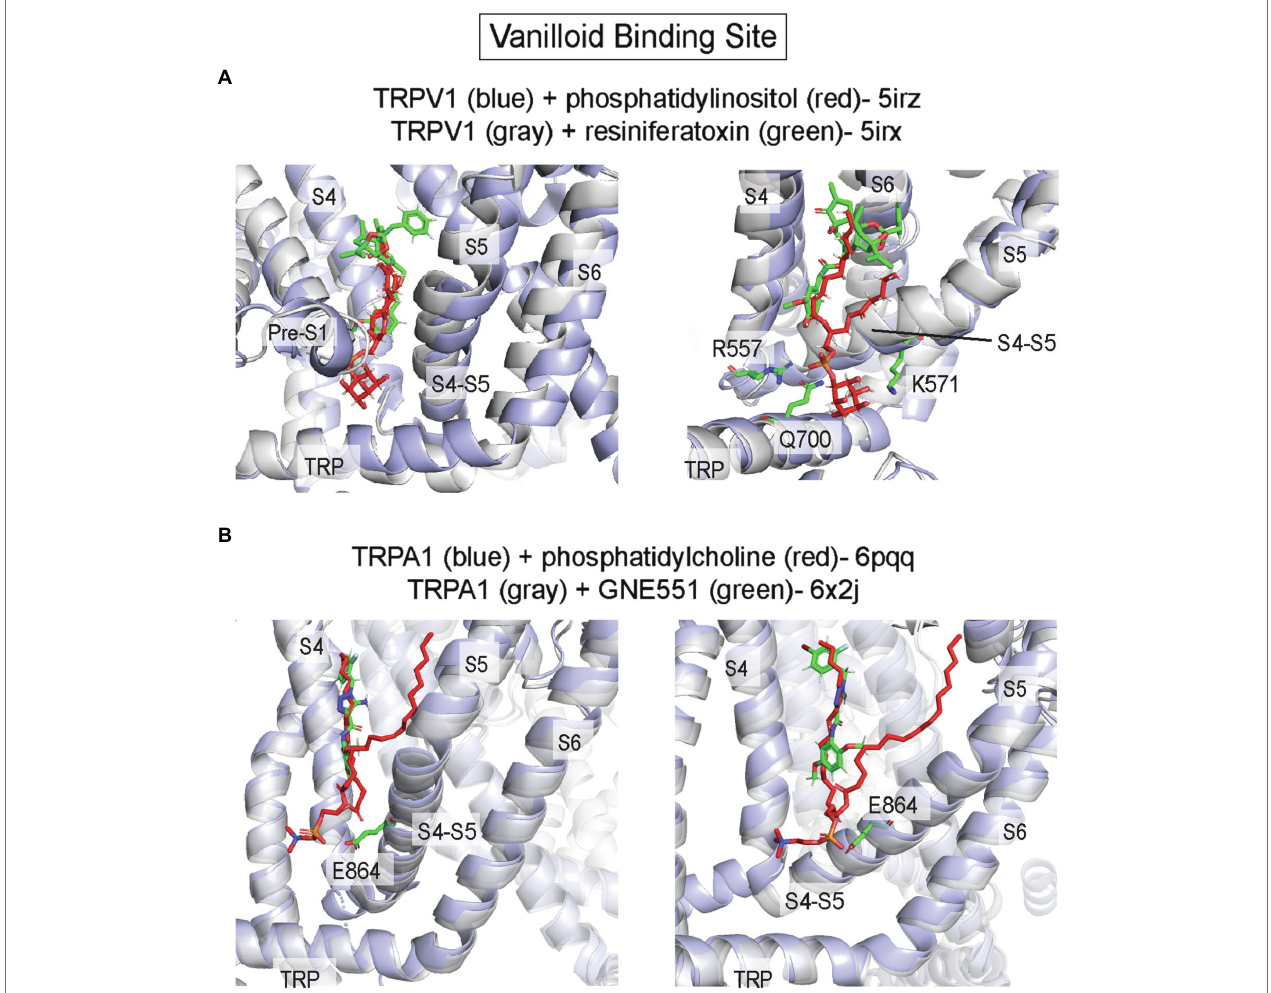
FIGURE 7 | Vanilloid binding site in TRP channels. (A) TRPV1 with phosphatidylinositol (PI; pdb 5irz) and TRPV1 with resiniferatoxin (RTX; pdb 5irx). The headgroup of PI is predicted to interact with R557, K571 and Q700. Replacement of PI in this pocket with RTX leads to outward movement of the S4-S5 linker, TRP domain and S6 producing opening of the channel pore. (B) TRPA1 with phosphatidylcholine (pdb 6pqq) and TRPA1 with GNE551 (pdb 6x2j). E864 in the S4-S5 linker is predicted to interact with the phospholipid headgroup. There is no difference in protein conformation between lipid-bound and agonist-bound